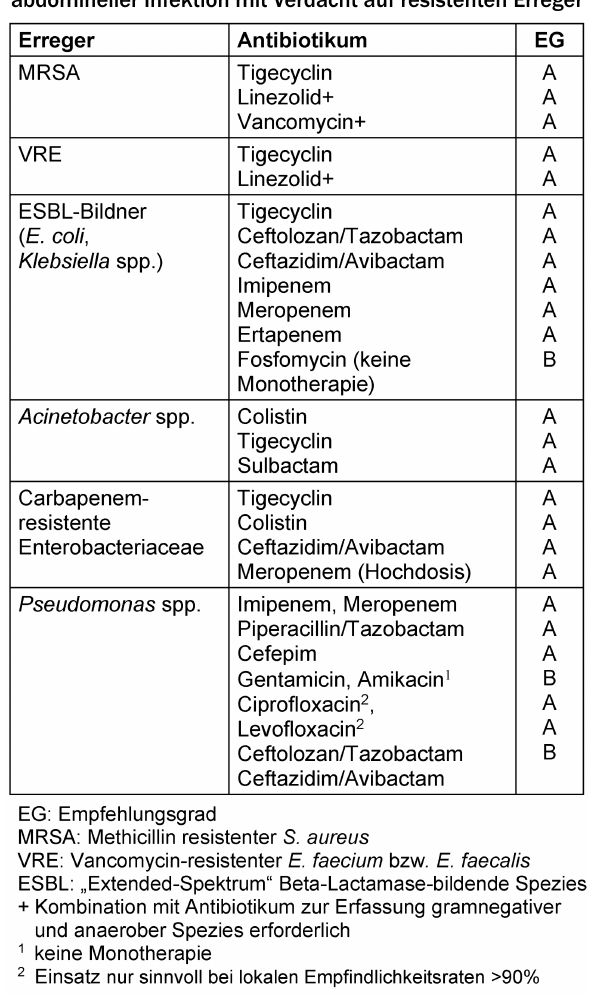
Tabelle 2: Kalkulierte Antibiotika-Therapie bei